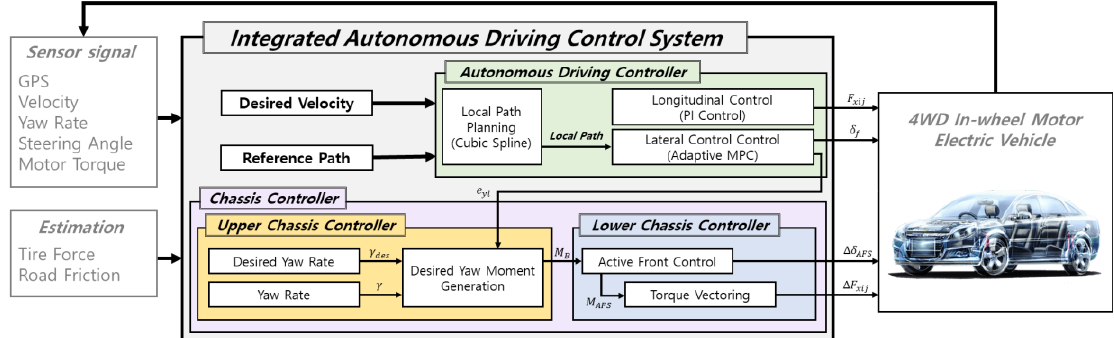
Figure 3. The architecture of the integrated autonomous driving (AD) control system.